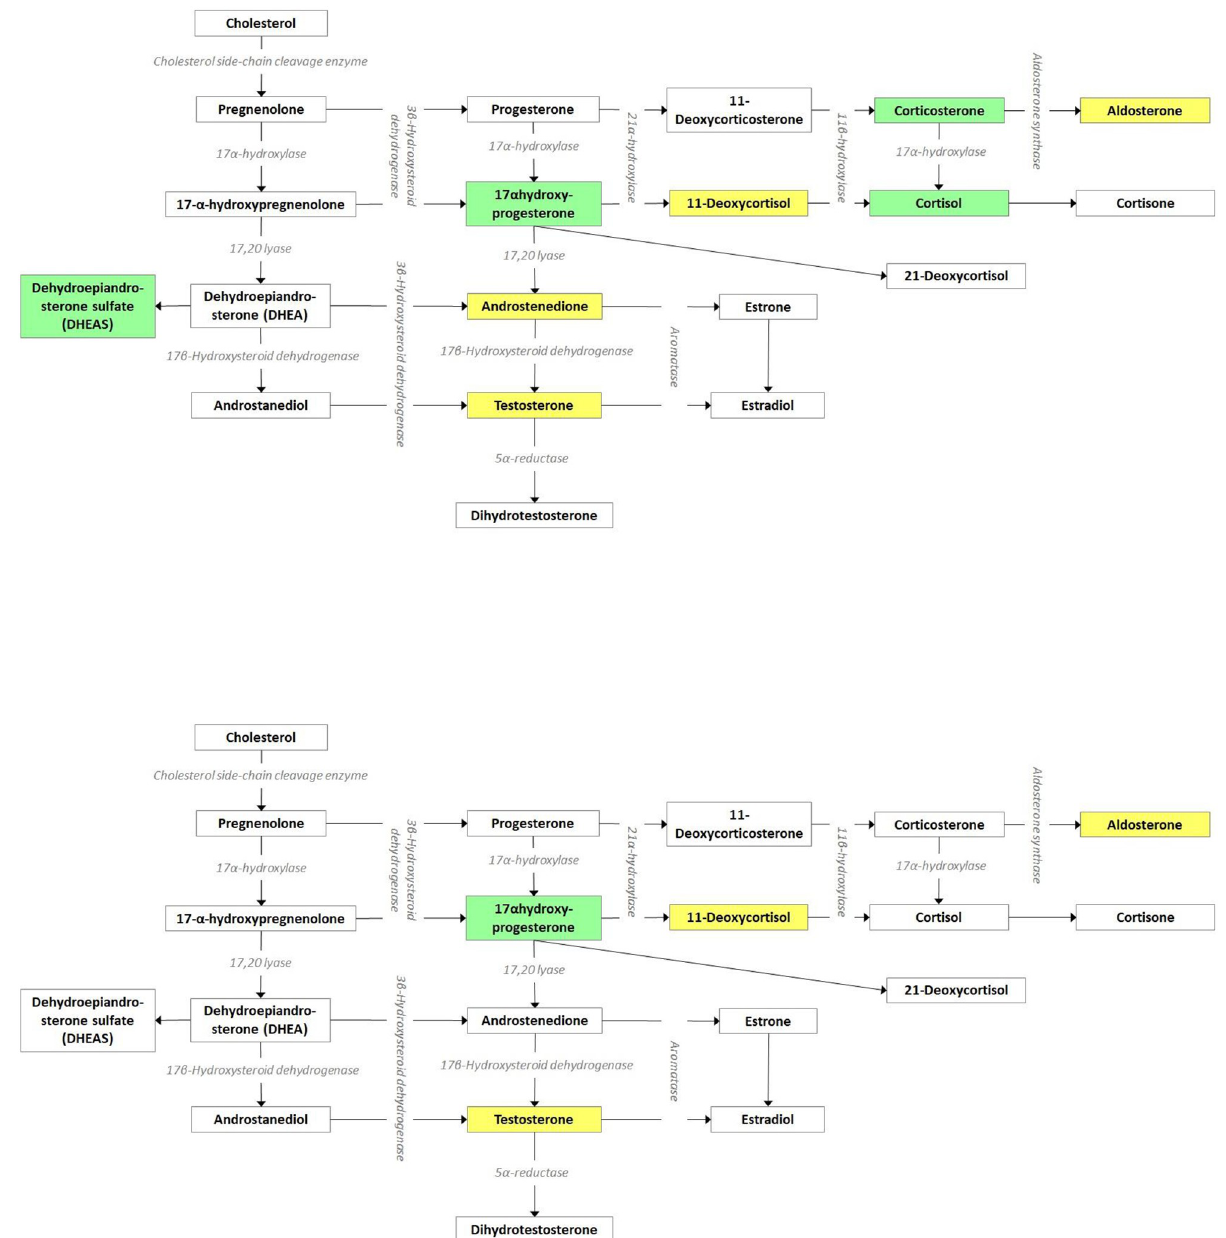
Fig 3. The follicular fluid steroids cascade in the two study groups. Data are presented separately for those who did (lower panel) and did not (higher panel) receive letrozole. Statistically significant increases were highlighted in yellow. Statistically significant decreases are highlighted in green (for details, see Table